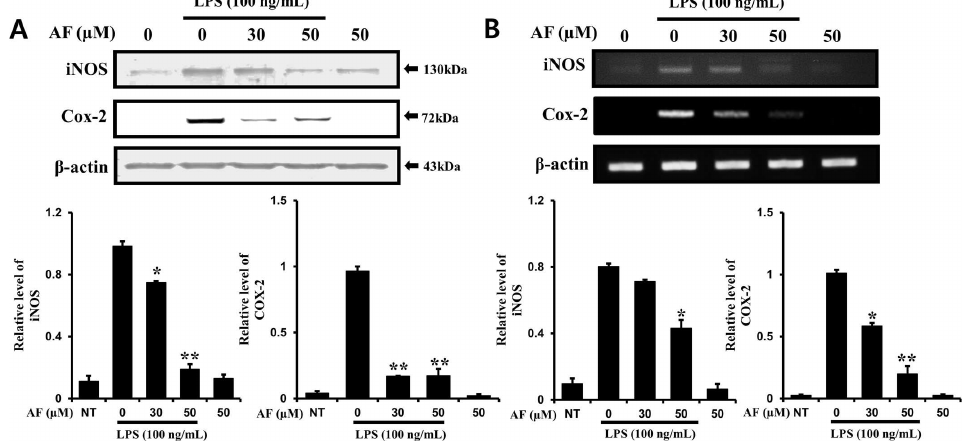
Fig 3. AF inhibits iNOS and COX-2 mRNA and protein levels in RAW 264.7 macrophage cells. RAW264.7 macrophage cells were treated with 0–50 mM AF and then co-treated with LPS for 24 h. Protein (A) and mRNA (B) levels were determinedby RT-PCR and Western blot analysis, respectively.The data shown are representative of three independent experiments and indicatethe mean ± SEM. * p < 0.05 and ** p < 0.01 indicatesignificantdifferences from the LPS alone-treated